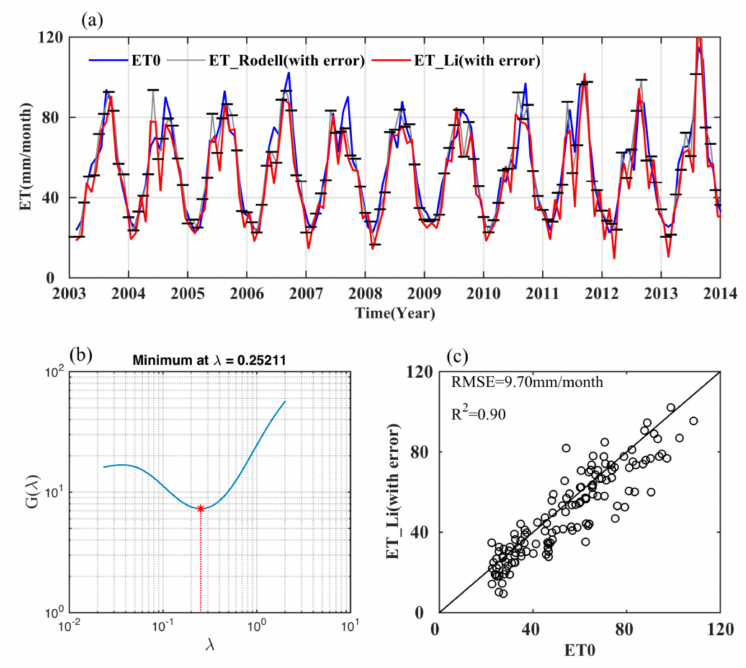
Figure 4. ( a ) Monthly ET estimated from simulated GRACE TWS and daily P and R observations with error using the method introduced in this study; ( b ) The regularization factor determined by the GCV method; ( c ) The correlation ( R 2 ) and RMSE between the simulated ET observations and ET estimations using our